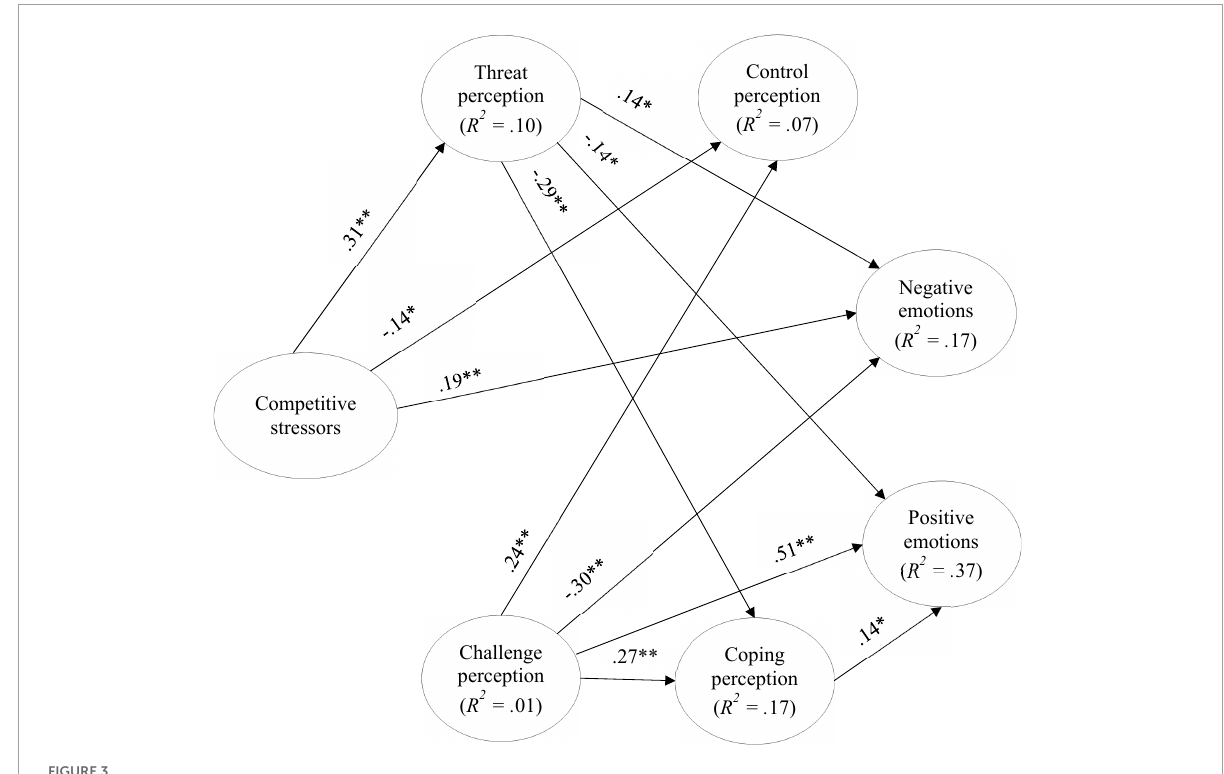
FIGURE3 Standardized coefficients of the partial mediation model. * p < 0.05; ** p < 0.01; only significant paths are